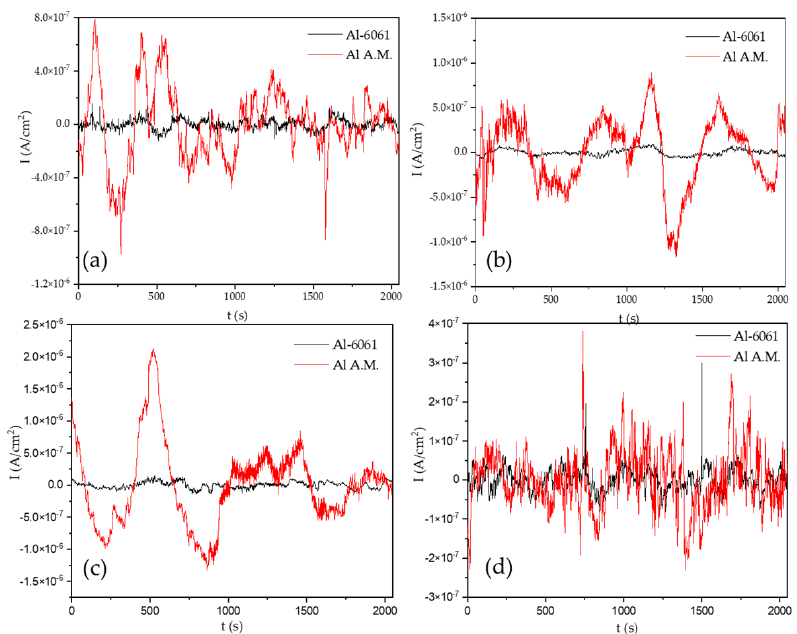
Figure 3. Time series electrochemical current noise (ECN) data in H 2 O solution, ( a ) 0 h, ( b ) 24 h, ( c ) 48 h, and ( d ) 120 h.